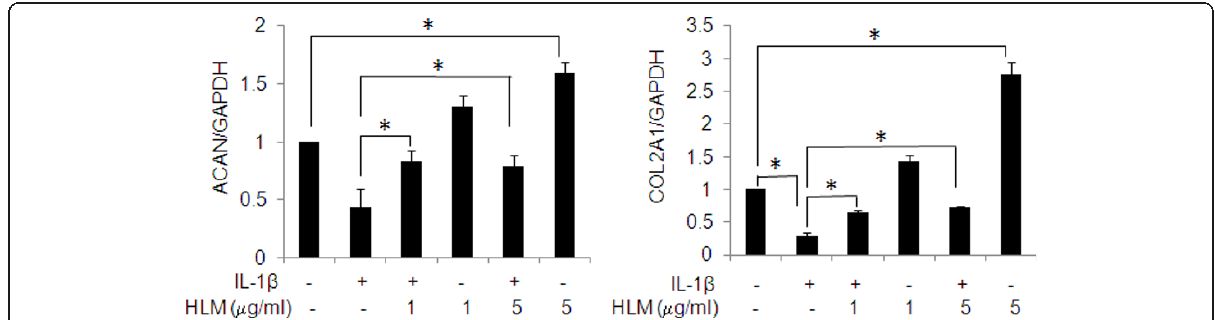
Figure 4 Effect of HLM ( Uncaria tomentosa ., Boswellia spp ., Lepidium meyenii and L-Leucine ) on the IL-1 b -induced gene expression of ACAN and COL2A1 in IL-1 b -stimulated OA chondrocytes . Chondrocytes were pretreated for 2 h with HLM (1 and 5 μ g/ml) and then stimulated or not stimulated with IL-1 b (5 ng/ml) for 24 h, expression of ACAN (A) and COL2A1 (B) was analyzed by Real time-PCR. Relative gene expression was normalized to GAPDH and compared with un-stimulated control. Value represents Mean ± SD of three different experiments run in duplicate. * p < 0.05.